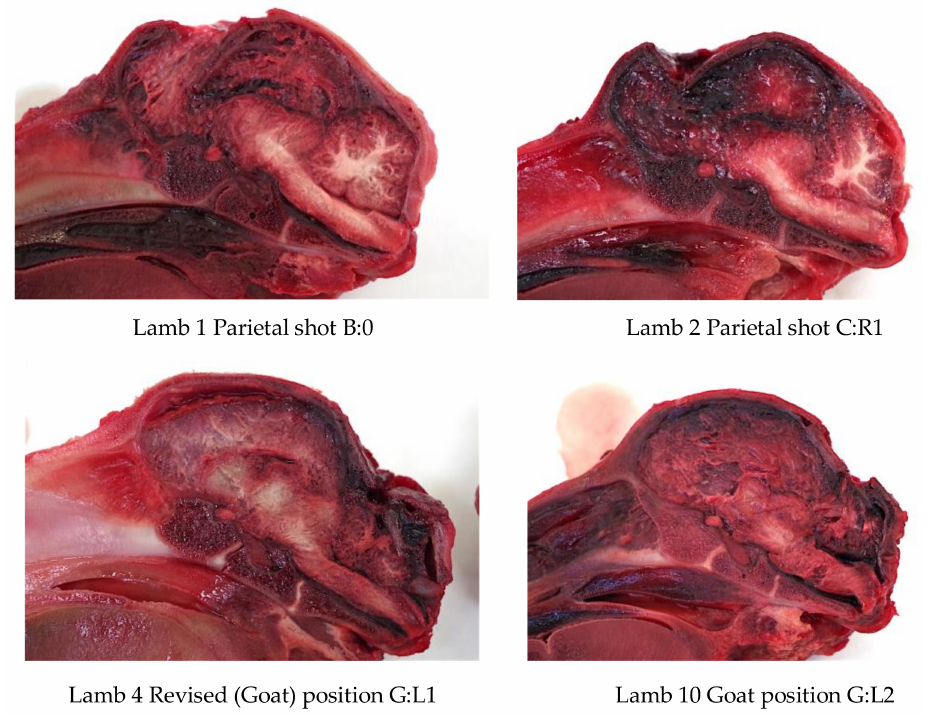
Figure 17. Trial 2 using 1.25-grain cartridges, variation in fracture indentation and brain haemorrhages based on application